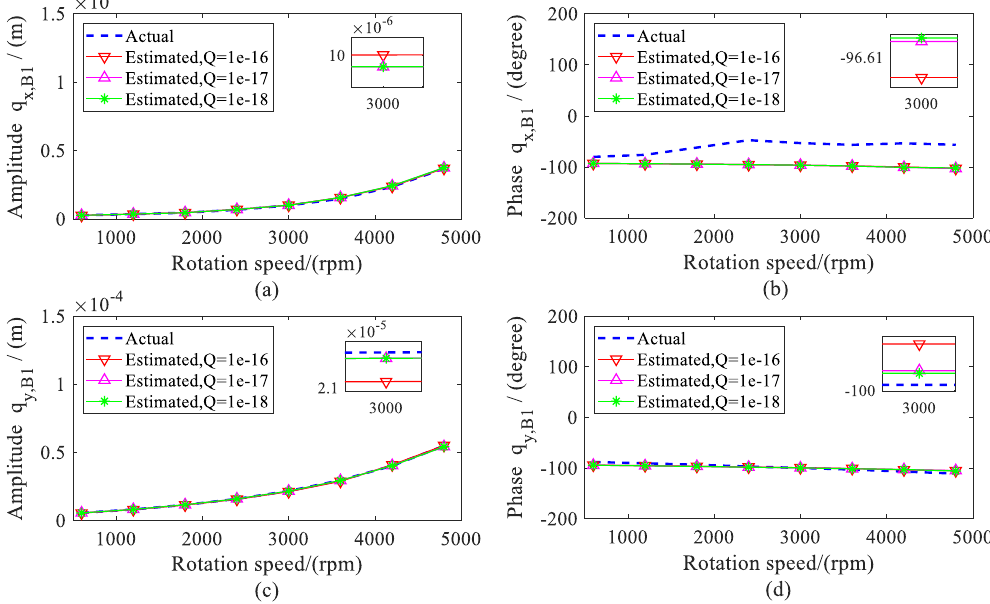
Figure 5. Actual and estimated displacements of bearing 1; ( a ) amplitude of q x, B 1 ; ( b ) phase of q x,B 1 ; ( c ) Amplitude of q y, B 1 ; ( d ) phase of q y, B 1 .